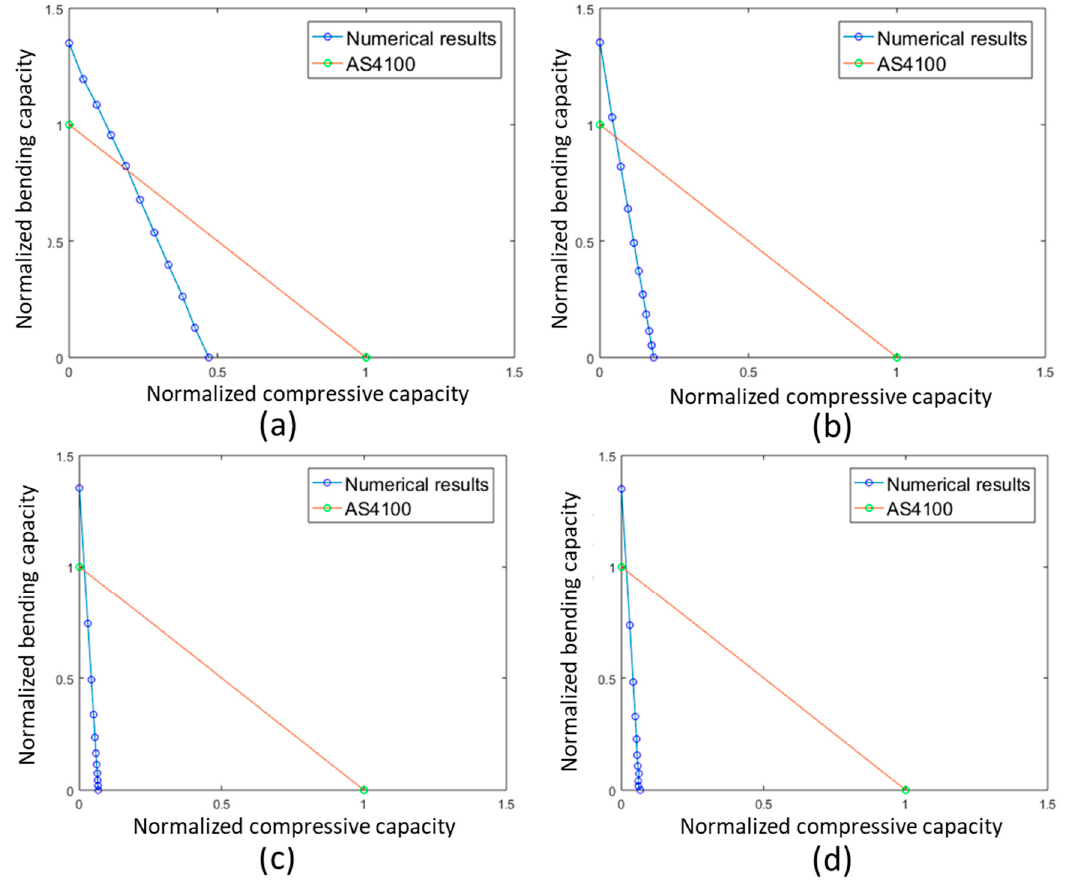
Figure 23. Interaction curves of the members with different L/R ratios: ( a ) for 0.4 L/R ratio; ( b ) for 0.8 L/R ratio; ( c ) for 1.2 L/R ratio; ( d ) for 1.8 L/R ratio.